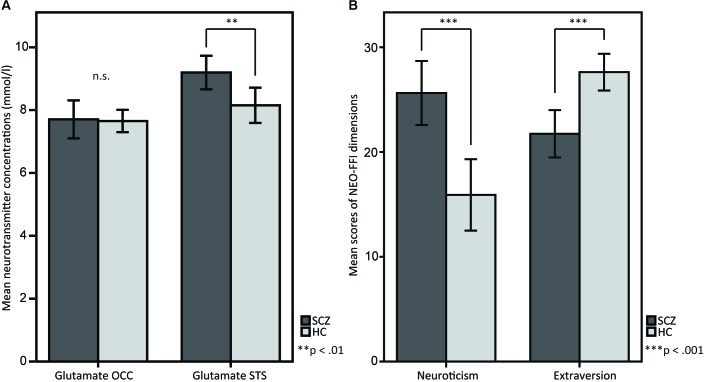
T-tests between SCZ and HC for (A) glutamate in the OCC and glutamate in the STS, and for (B) the NEO-FFI dimensions neuroticism and extraversion. (A) The barplots show OCC and STS mean glutamate concentrations in SCZ and HC. Glutamate concentrations in the STS are elevated in SCZ compared to HC, whereas OCC glutamate concentrations do not show any differences. (B) The barplots show differences between SCZ and HC in the personality dimensions neuroticism and extraversion, measured by the NEO-FFI.